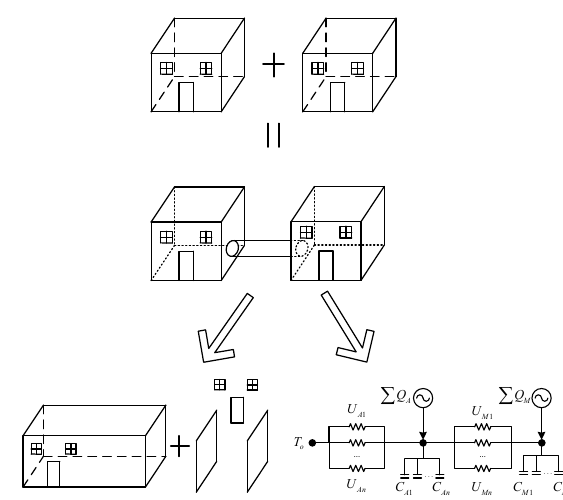
Figure 3. The virtual house as an aggregation of two houses.